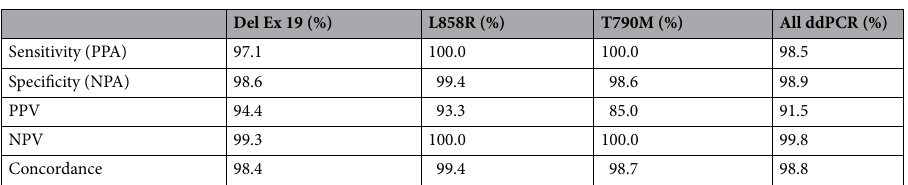
Table 1. Correlation and predictive measures for our sequencing assay, assuming ddPCR results as the gold standard. Sensitivity and specificity of sequencing versus ddPCR are also shown in Fig. 6. A majority of discordant calls are supported by tissue, making the true sequencing specificity and PPV higher than the reported values vs.